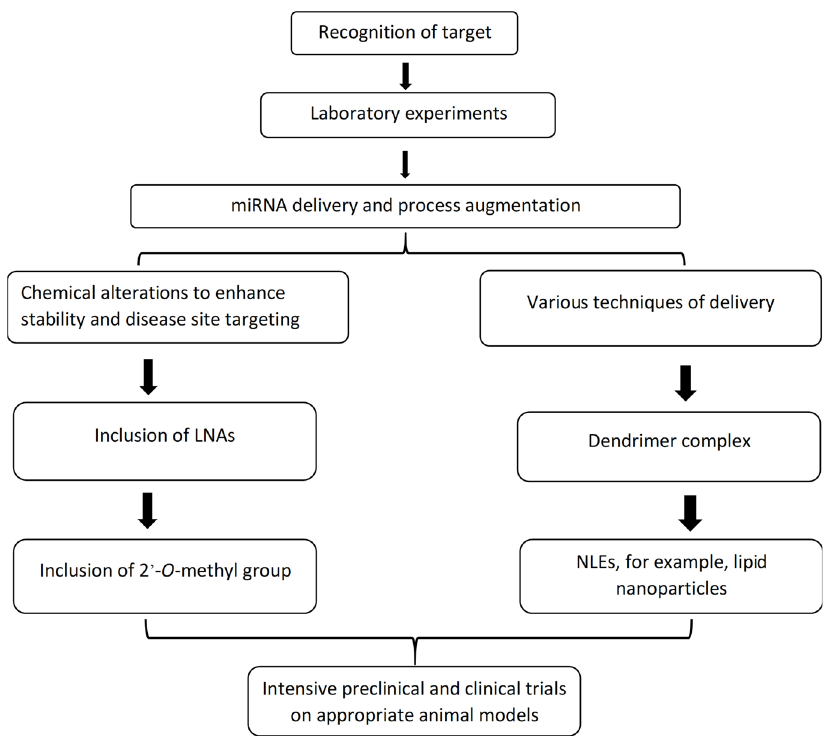
Figure 3. The major stages in the production of miRNA therapeutics are described. The initial step for the preparation of miRNA therapeutic is the proper identification of candidates of miRNA by in vitro experiments. The generation of chemical